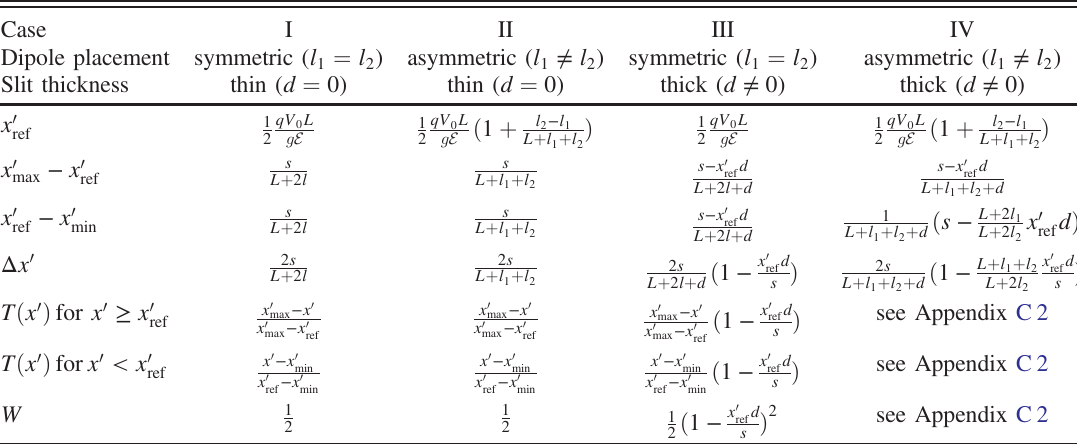
TABLE II. Analytic formulas corresponding to the geometric models in Fig. 2 for V 0 ≥ 0 . Results for V 0 < 0 obey the same formulas with V 0 → j V 0 j and the x -axis